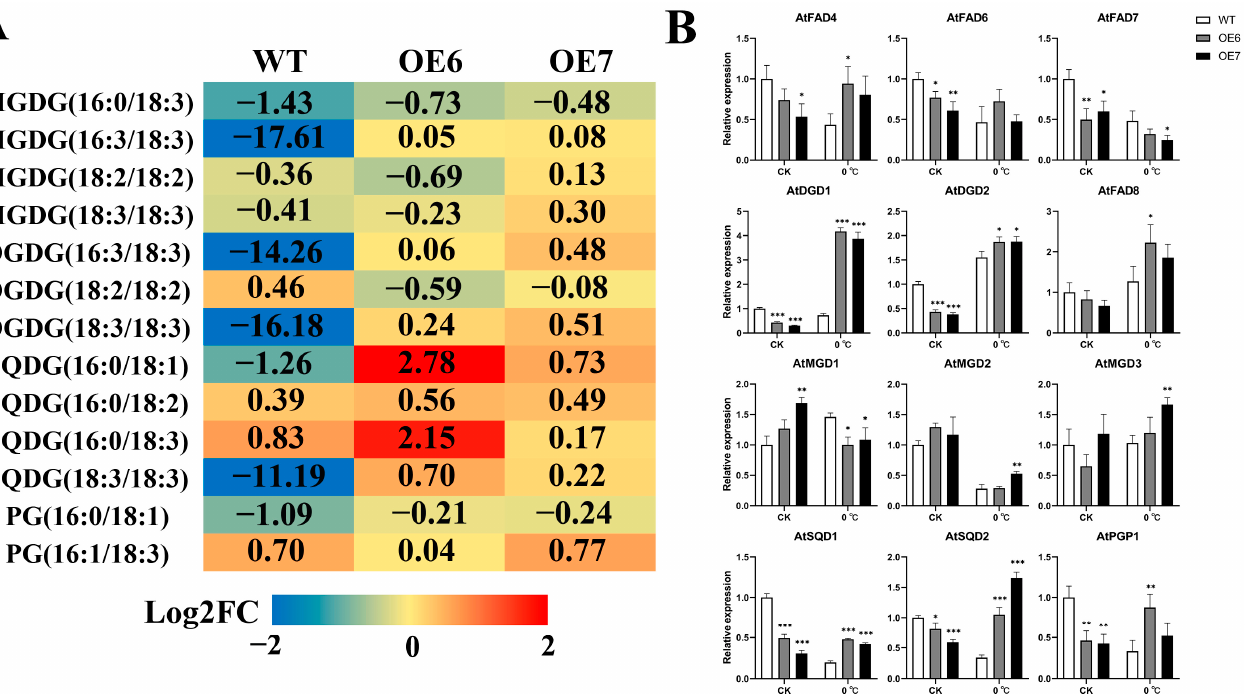
Figure 7. Changes in lipid and lipid-related gene expression at low temperatures in WT and transgenic Arabidopsis . ( A ) Changes in FAD8 -related lipid quantity in Arabidopsis leaves under low-temperature stress (0 ◦ C). The number in each color block represents the Log2 (fold-change) of the lipid, with negative numbers representing down-regulated lipids. Red indicates an increase in quantity and blue indicates a decrease in quantity. ( B ) Expression levels of lipid-related genes in WT and transgenic lines under low-temperature stress (0 ◦ C). Error bars, ± SD. Each analysis was repeated with three biological replicates. Asterisks denote signi fi cant di ff erences (as compared with the WT): * p < 0.05; ** p < 0.01; *** p < 0.001.